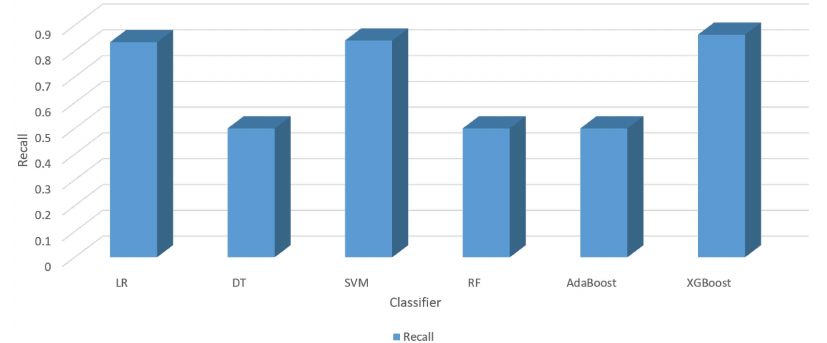
Figure 5. Evaluation results for the classifiers (Recall).